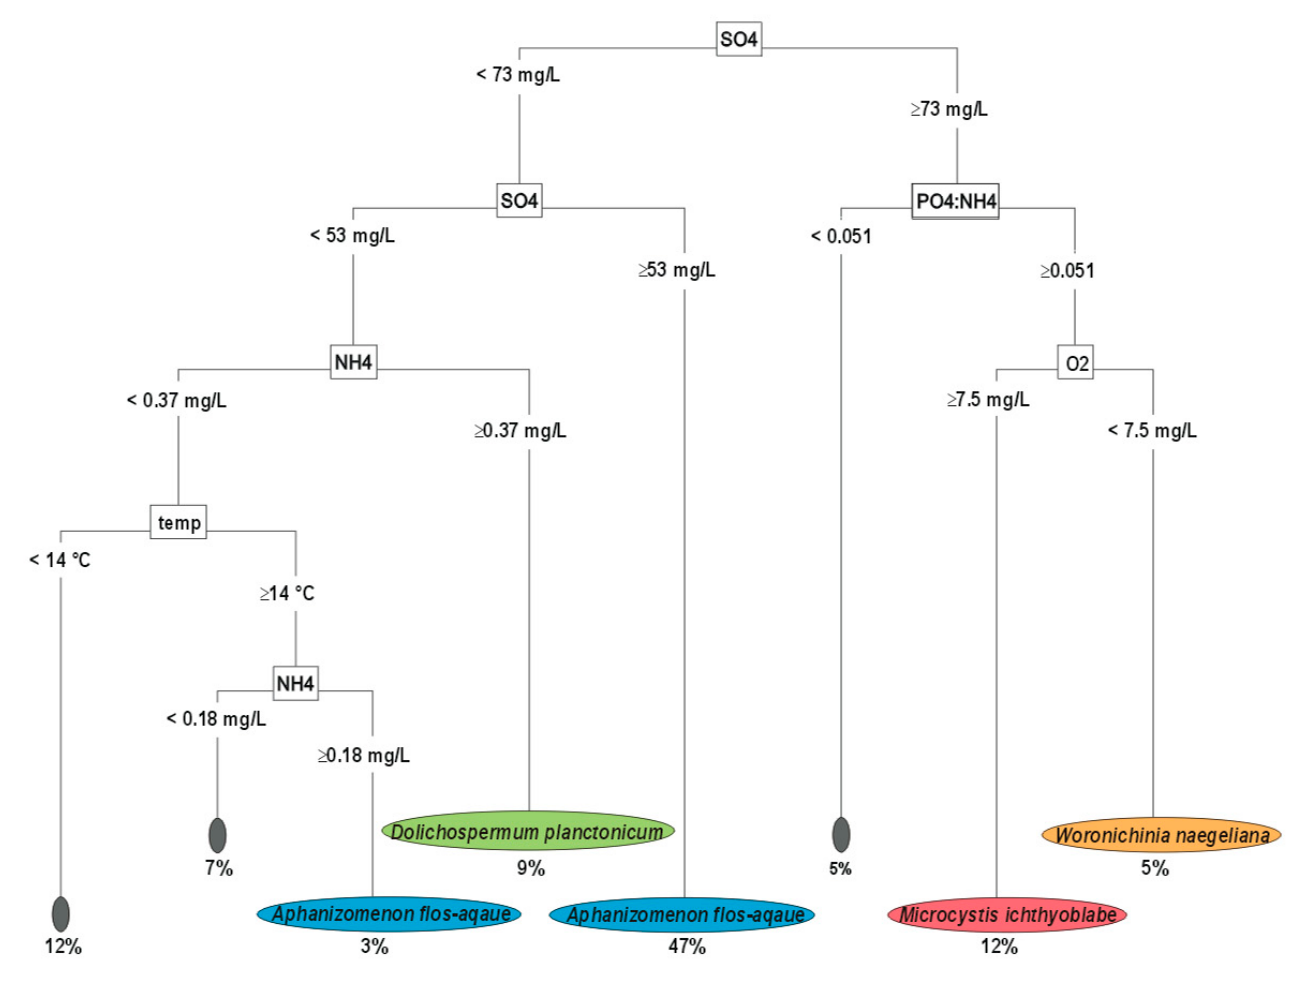
Figure 2. Decision tree of factors explaining the dominance of cyanobacterial species—bottom layer. Grey boxes—no dominant cyanobacteria; blue and green boxes—dominance of filamen- tous diazotrophic cyanobacteria ( A. flos-aquae , D. planctonicum ); red and orange boxes—dominance of Chroococcales ( M. ichthyoblabe , W. naegeliana